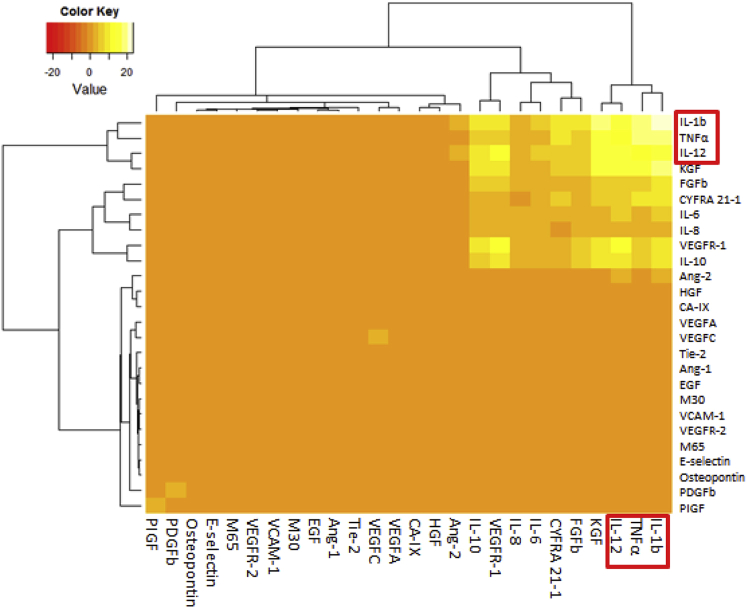
Heat Map (With Clustergram) of the Variance–Covariance Matrix After Data Were Log-Transformed and Each Marker Scaled by Its Mean Value for the Baseline Time PointAbbreviations: Ang = angioprotein; CA-IX = carbonic anhydrase; CYFRA 21-1 = cytokeratin-19 antigen; EGF = epidermal growth factor; FGFb = basic fibroblast growth factor; HGF = hepatocyte growth factor; IL = interleukin; KGF = keratinocyte growth factor; M30 = cytokeratin 18 cleaved; M65 = cytokeratin 18 intact; PDGFb = platelet-derived growth factor B; PIGF = placenta growth factor; Tie-2 = tyrosine kinase 2; TNF = tumor necrosis factor; VCAM = vascular cell adhesion molecule; VEGF = vascular endothelial growth factor; VEGFR = vascular endothelial growth factor receptor.